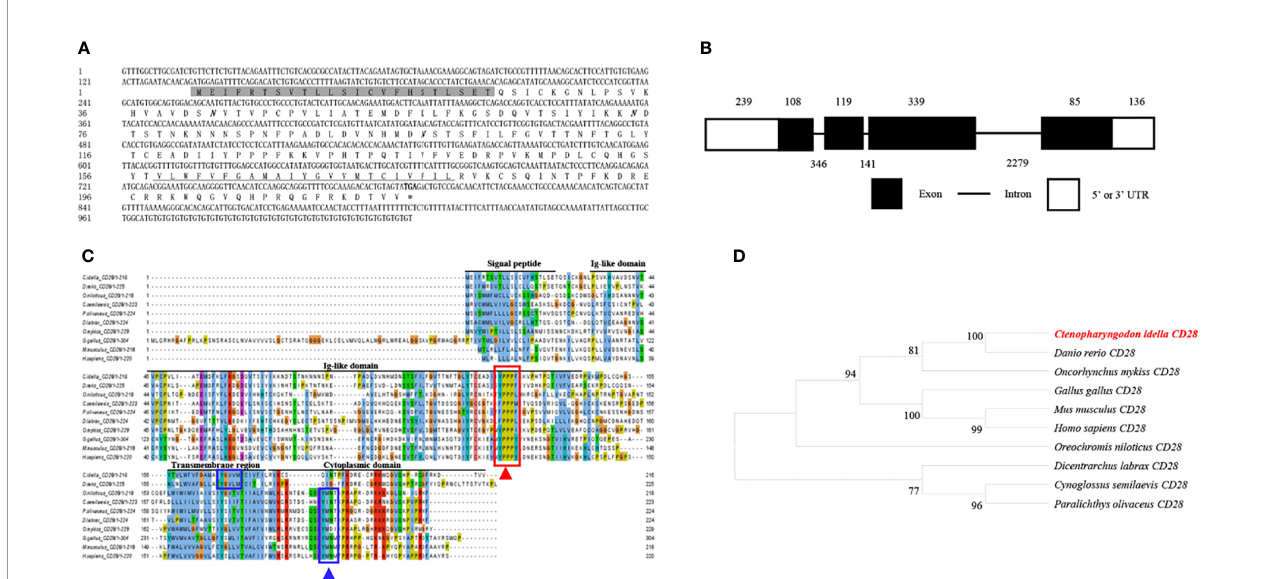
FIGURE 2 | Molecular cloning and bioinformatic analysis of the CD28 gene in grass carp. (A) The cDNA and deduced amino acid sequences of CD28. The signal peptide is shadowed, the transmembrane domain is underlined, and the stop codon is indicated by the asterisk. The predicted NGS locations are shown in bold and italic. (B) The exon/intron structure of the CD28 gene in grass carp. The rectangles represent the exons, and the lines between them indicate the introns. The black and white areas indicate the coding regions and the 5 ’ or 3 ’ UTRs, respectively. The exon and intron sizes (bp) are shown by the numbers above and below, respectively. (C) Multiple amino acid sequence alignment of the CD28 homologs. The sequence alignment was conducted using the ClustalX program. The predicted domains of grass carp CD28 were marked above the amino acid sequence. The conserved binding motifs for binding CD80/86 are indicated with a red rectangle. The conserved tyrosine-based motifs are indicated with blue rectangles. (D) Phylogenetic analysis of the CD28 homologs. The phylogenetic tree based on protein sequences was constructed using the neighbor-joining method bootstrapped 1000 times with the MEGA program. The grass carp CD28 is highlighted in red. The GenBank accession numbers of the used sequences are shown below: H. sapiens , CAD57003; M. musculus , ABH08508.1; G. gallus , NP_990642.1; D. rerio , XP_001923482.1; C. Idella , UGY70978.1; Cynoglossus semilaevis , AEM98131; O. niloticus , AMQ36815.1; Dicentrarchus labrax , AIK66542.1; Paralichthys olivaceus , MT019836.1; O. mykiss ,